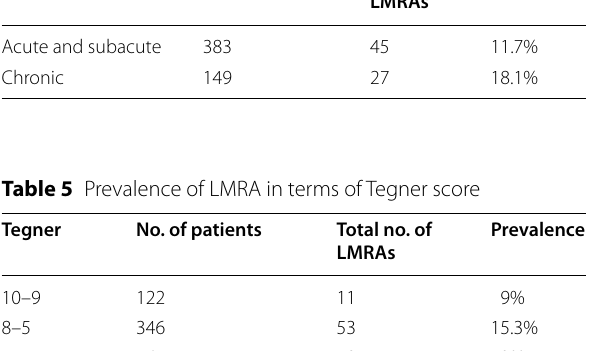
Table 4 Prevalence of LMRA in terms of timing of surgery Timing